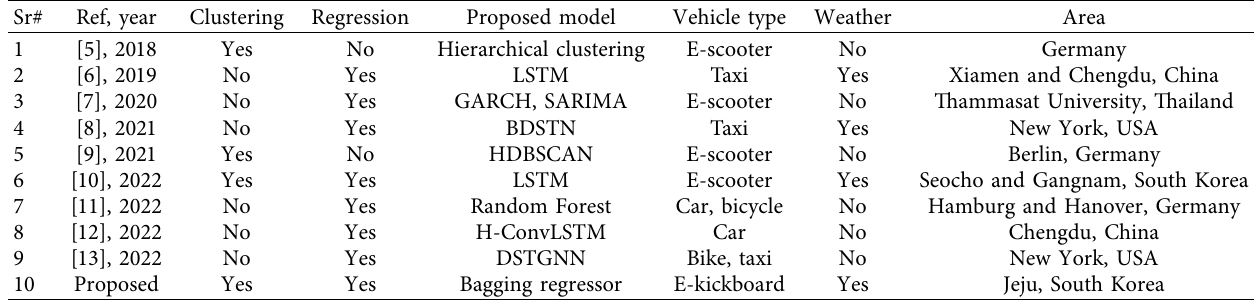
Table 1: Comparison of recent research contributions for vehicle demand